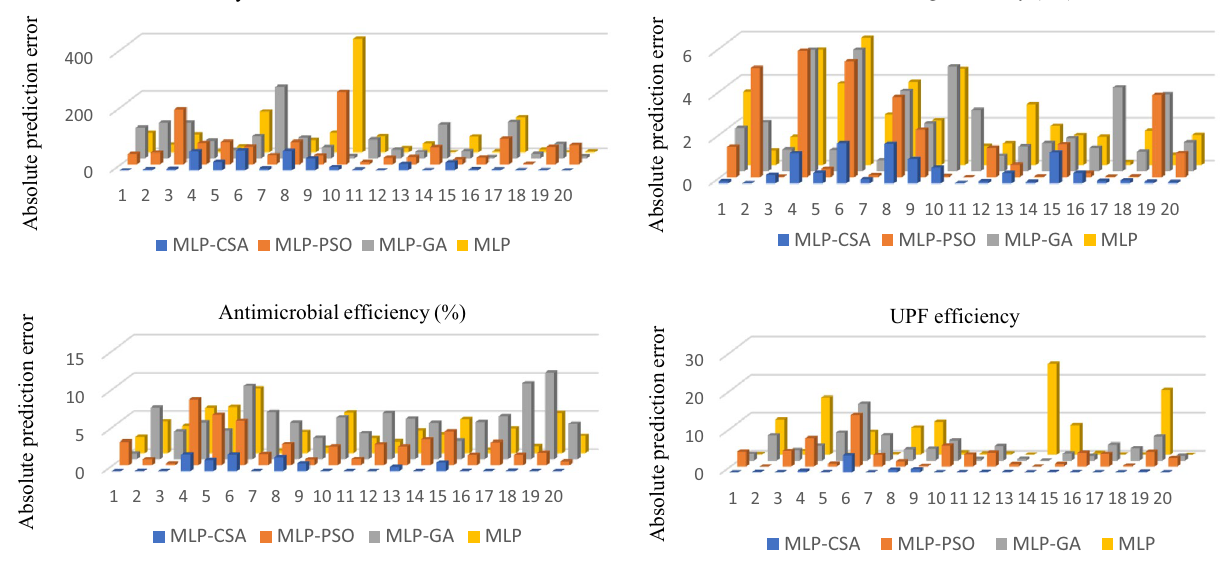
Figure 4. Absolute errors between predicted and actual values using MLP, MLP-CSA, MLP-PSO and MLP-GA.